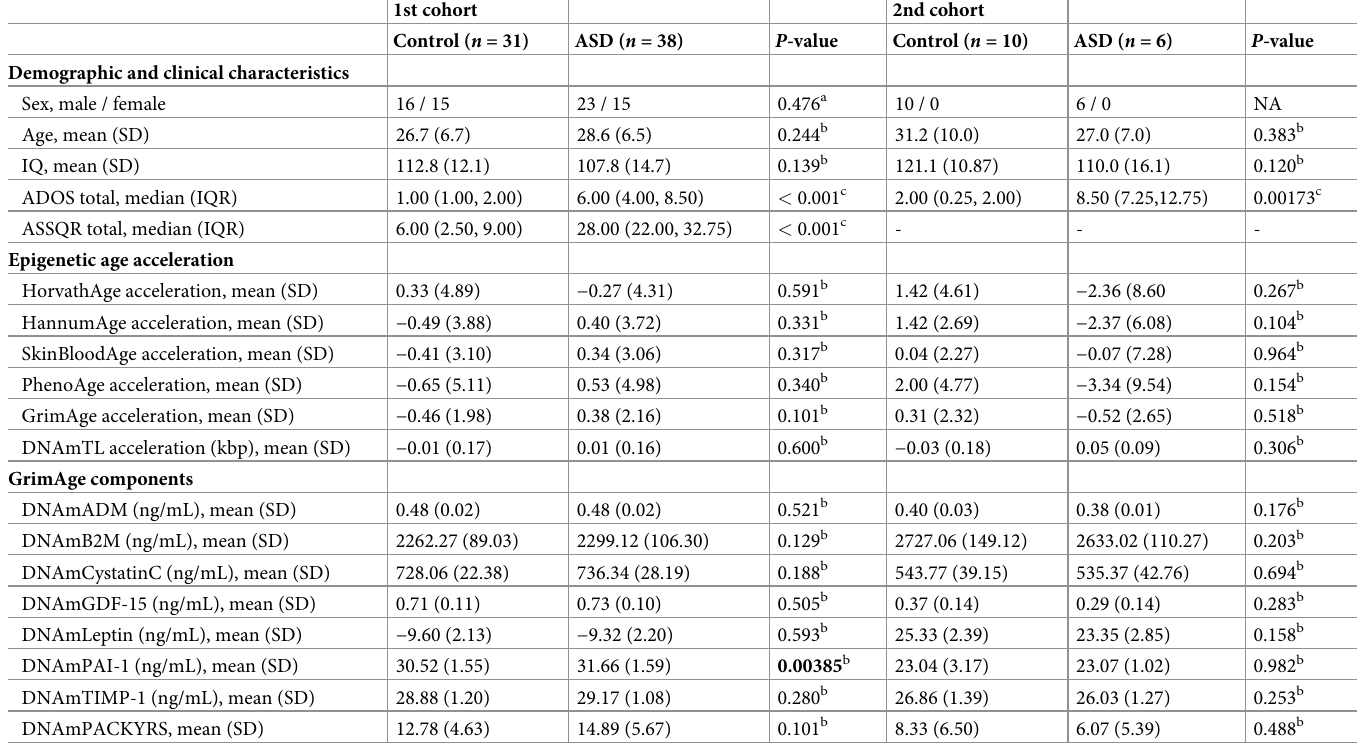
Table 1. Demographic and clinical characteristics as well as epigenetic clock